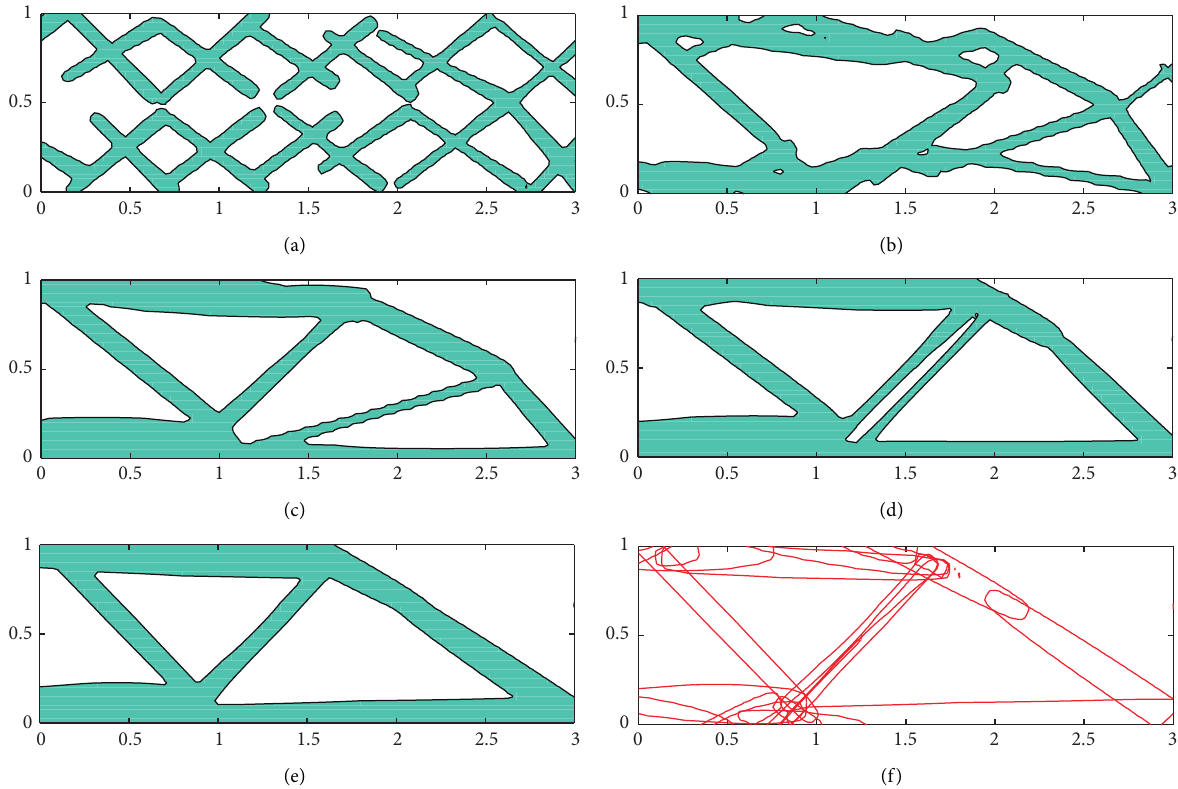
Figure 14: Some intermediate optimization results and the final results of the compliant mechanism example with the QVT